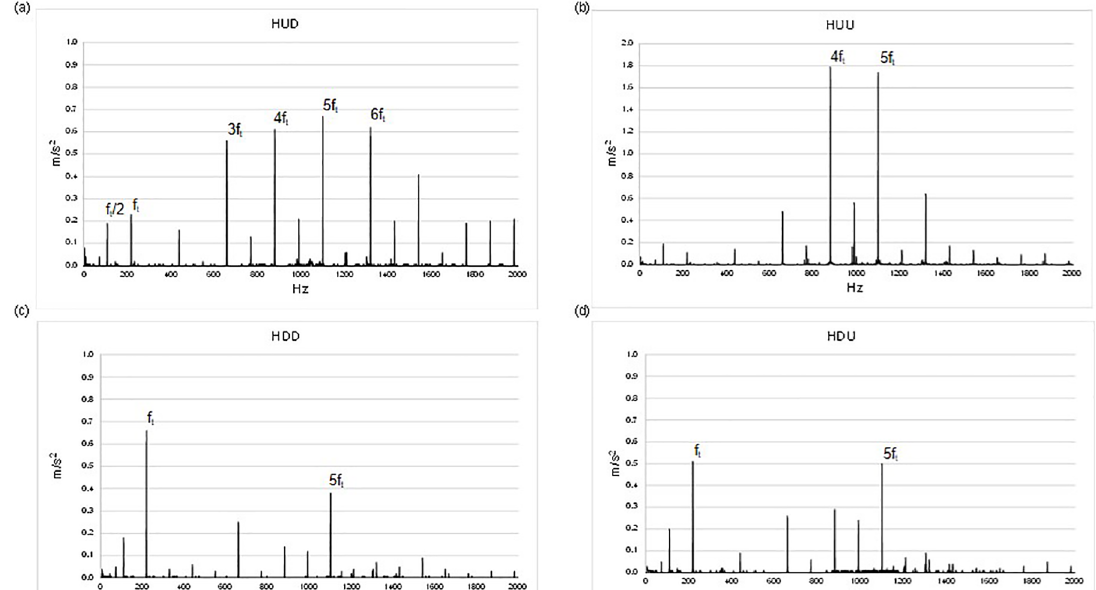
Figure 6. Spectrum of the acceleration signals for horizontal tool path orientations at inclined workpiece angle of 15º (a) HUD, (b) HUU, (c) HDD, (d) HDU